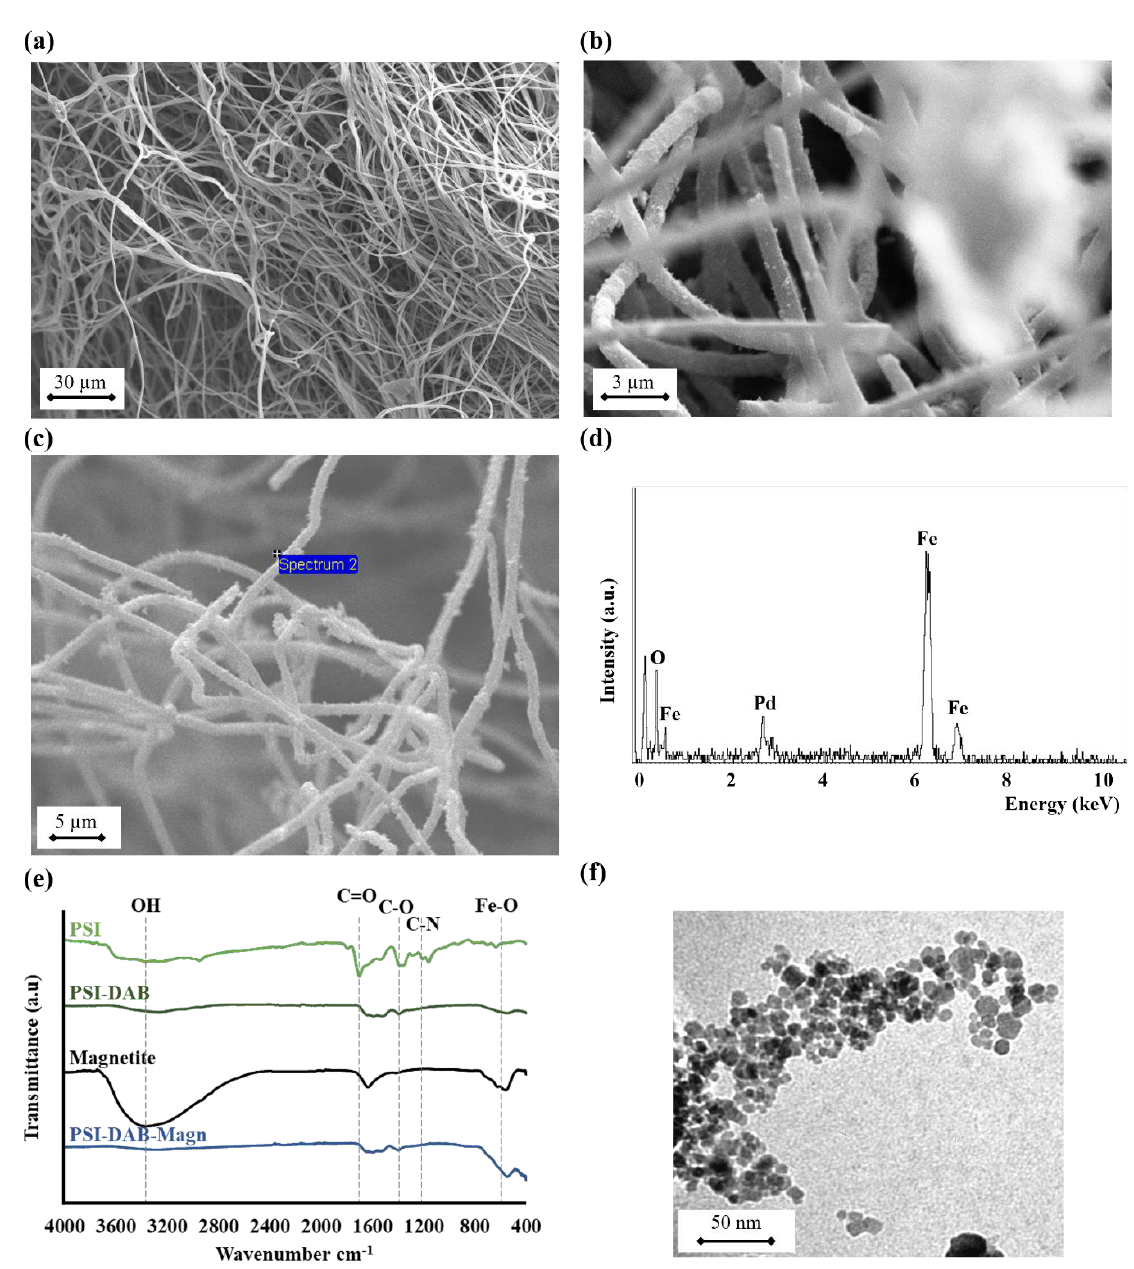
Figure 1. ( a , b ) SEM images of the iron oxide-containing fibrous PSI-DAB-Magn samples. ( c , d ) EDS scans of the same sample. ( e ) IR spectra of the PSI fibres, the crosslinked iron oxide-loaded fibres and the iron oxide particles themselves. ( f ) TEM image of the synthetised iron oxide.